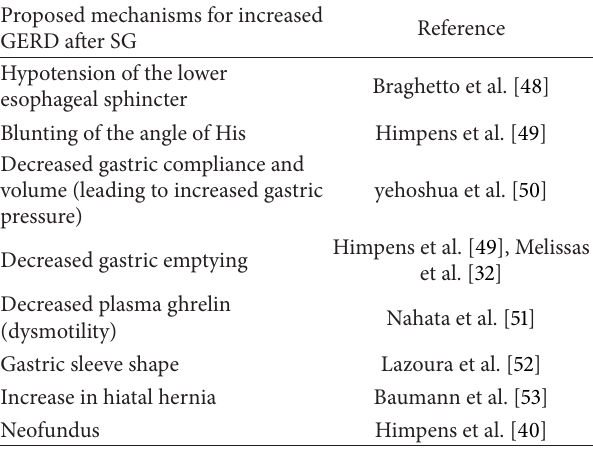
Table 3: Proposed mechanisms for an increase in prevalence of GERD symptoms after SG.